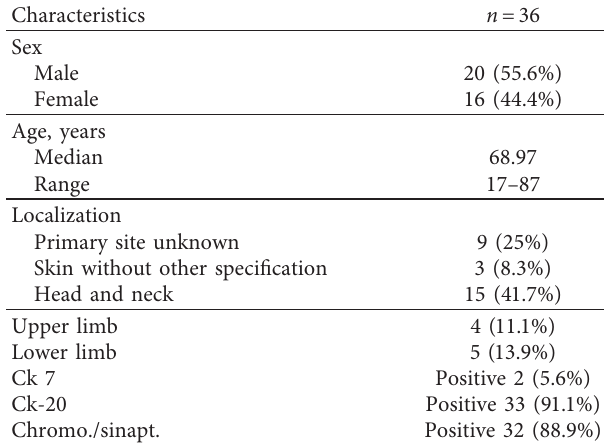
Table 2: Population.